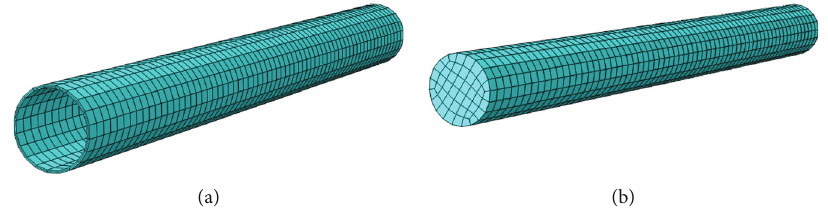
Figure 9: (a) Grid division of aluminum tube. (b) Concrete grid division.